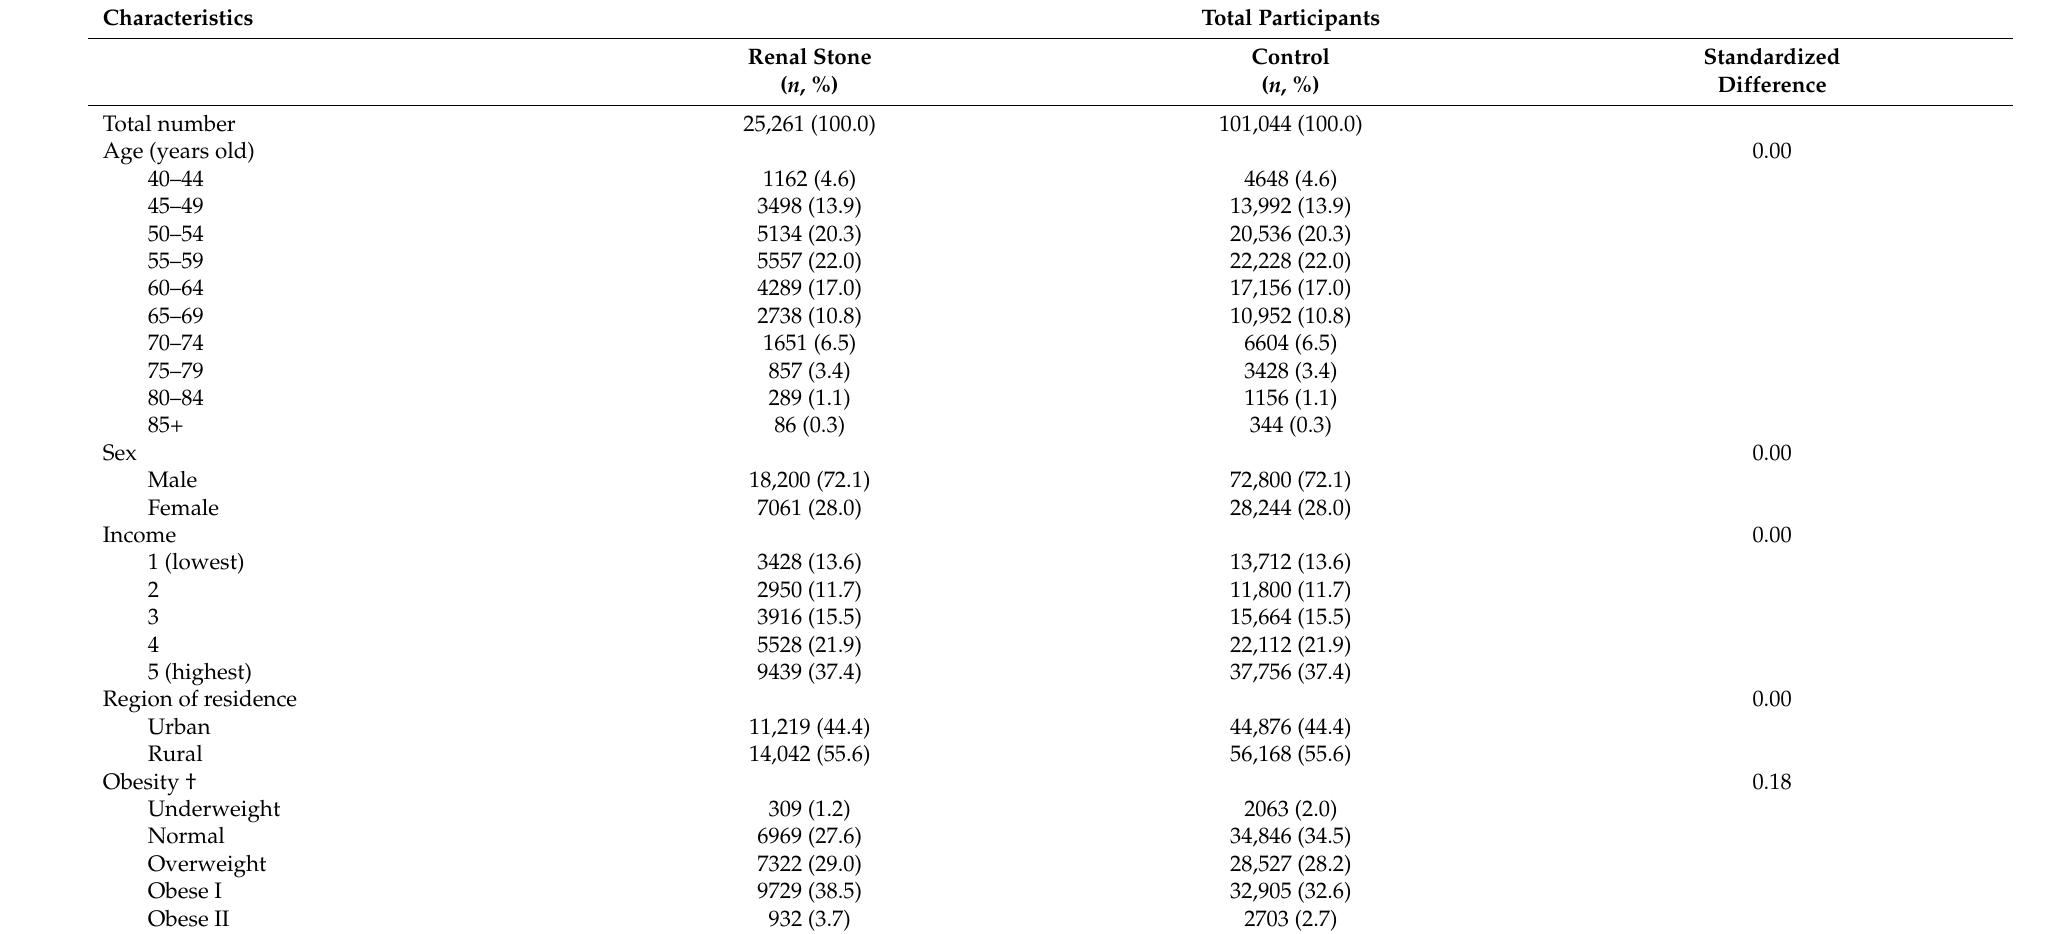
Table 3. General Characteristics of